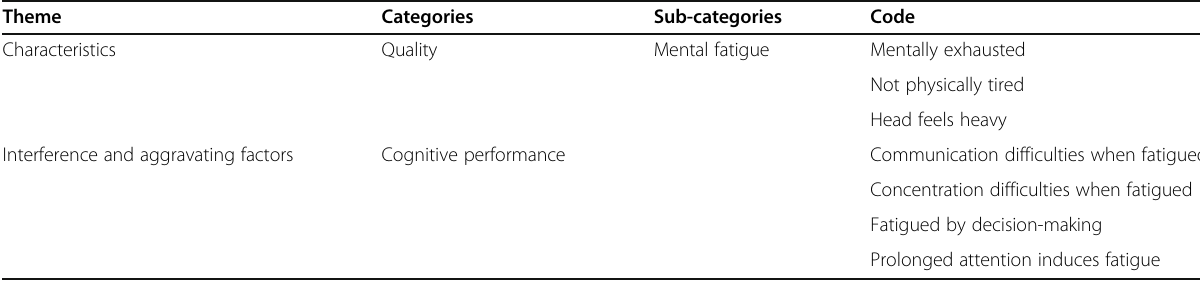
Table 1 Analysis, examples of themes, categories, sub-categories and codes